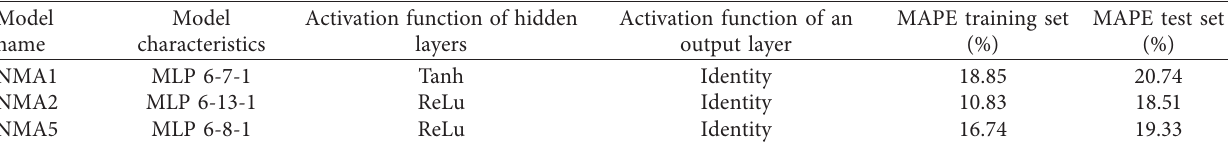
Table 6: Artificial neural network models for estimating reinforcement consumption (StandardScaler).